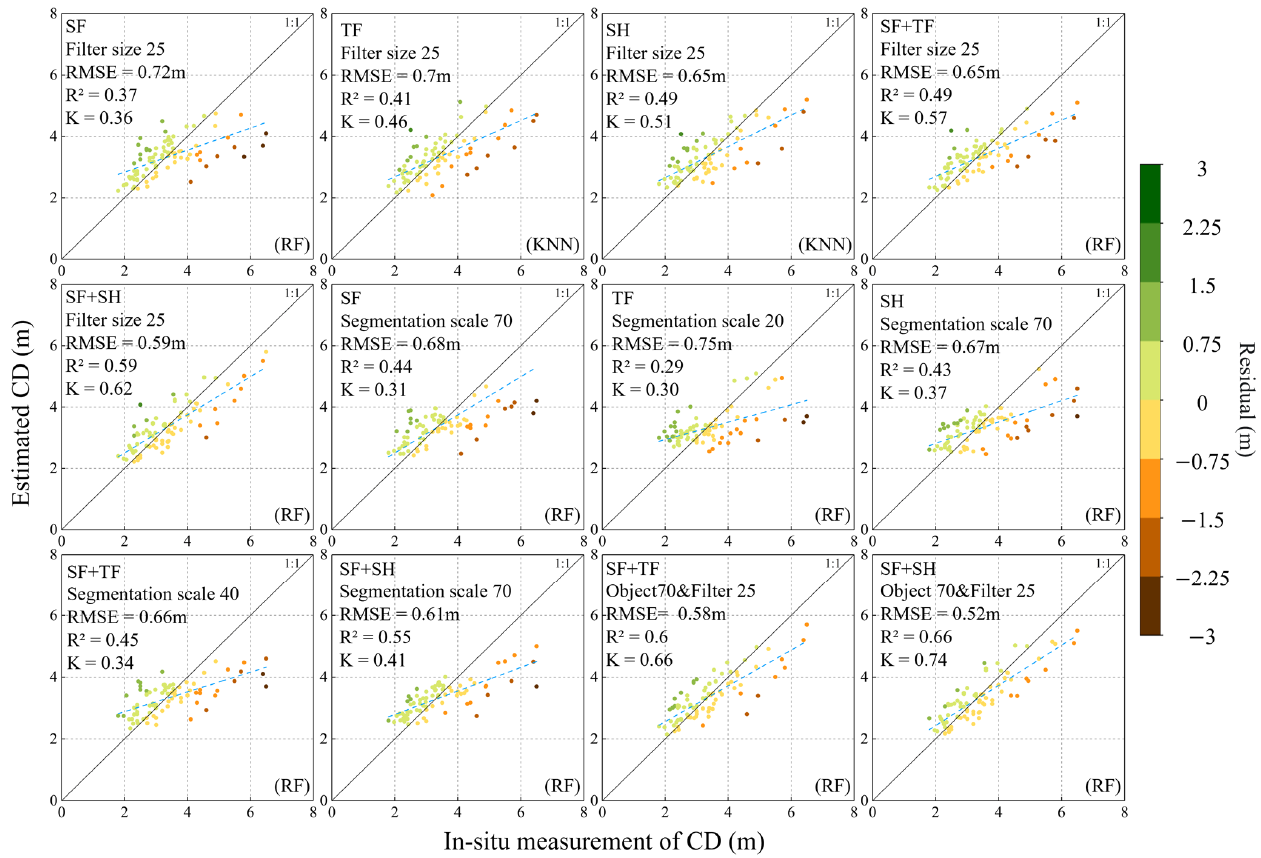
Figure 12. Scatterplots between predicted and ground-measured tree CDs using different variable sets with filter-based and object-based methods (the blue dashed line is the fitted line, the color of points is determined by the residuals between the predicted and ground-measured tree CD values, and K is the slope of the fitted line).